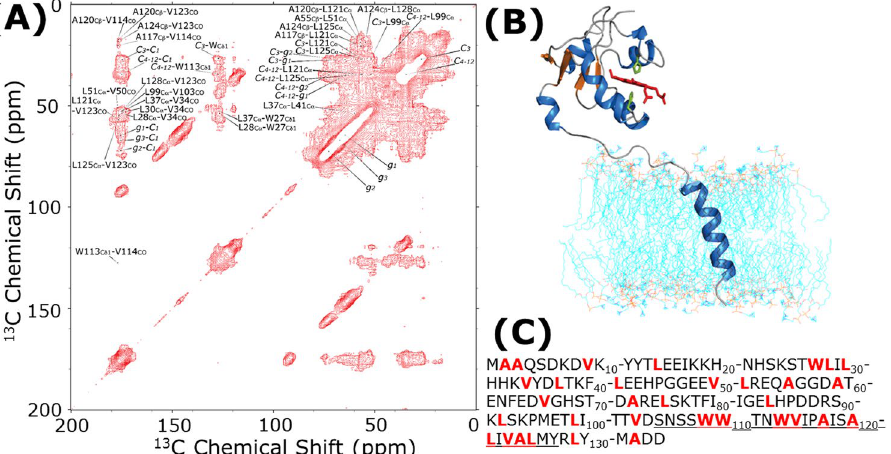
Figure 2. DNP sensitivity-enhanced two-dimensional 13 C- 13 C chemical shift correlation spectrum of selectively 13 C-labeled cytochrome b 5 incorporated into DMPC bilayers with a high efficient polarizing agent, AMUPol. (A) Two dimensional 13 C- 13 C proton driven spin diffusion (PDSD) chemical shift correlation spectrum